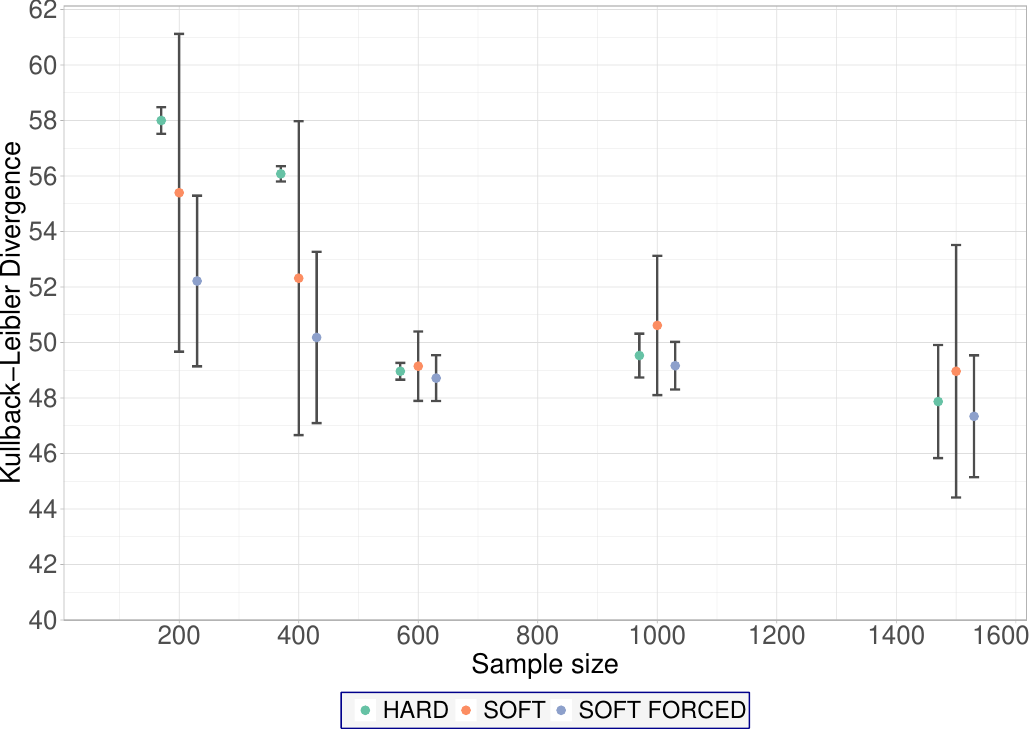
Figure 2. Leaf A. No EM algorithm proves to be more effective than the others (data sets with 5% missing data generated from the Alarm BN).